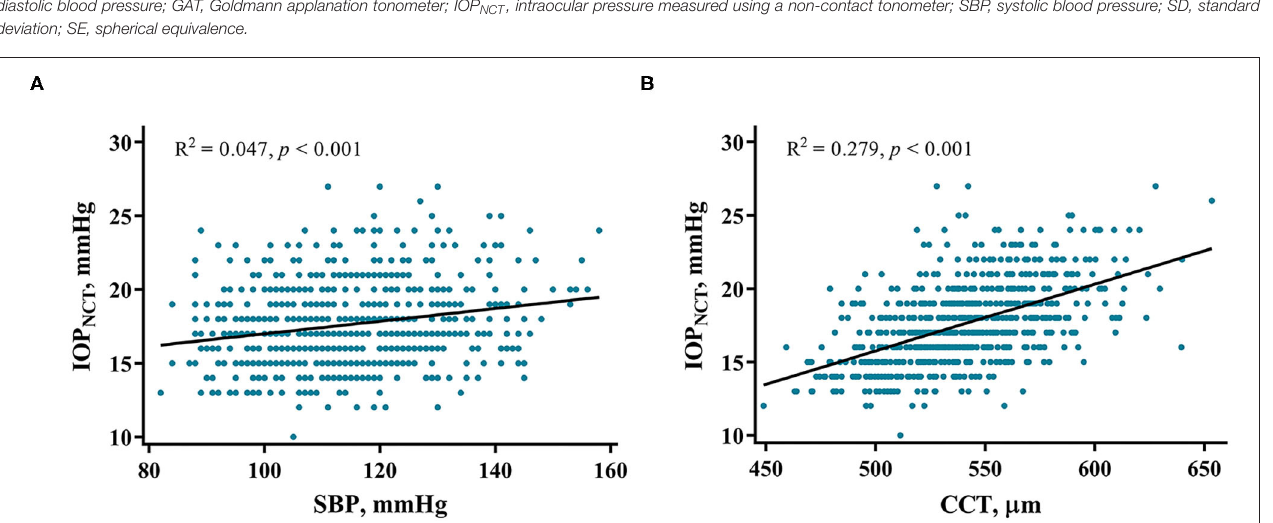
FIGURE 3 | Correlations between IOP NCT values and risk factors. Regression plots show systolic blood pressure (SBP) (A) and central corneal thickness (CCT) (B) effect on IOP NCT with R 2 = 0.047 and 0.279, respectively. The full lines indicate regression lines. IOP NCT , intraocular pressure measured with non-contact